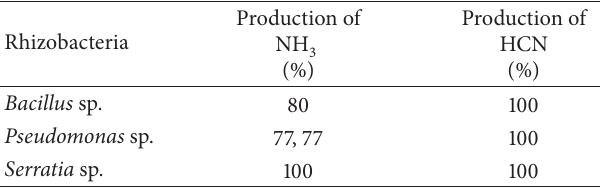
Pigment production